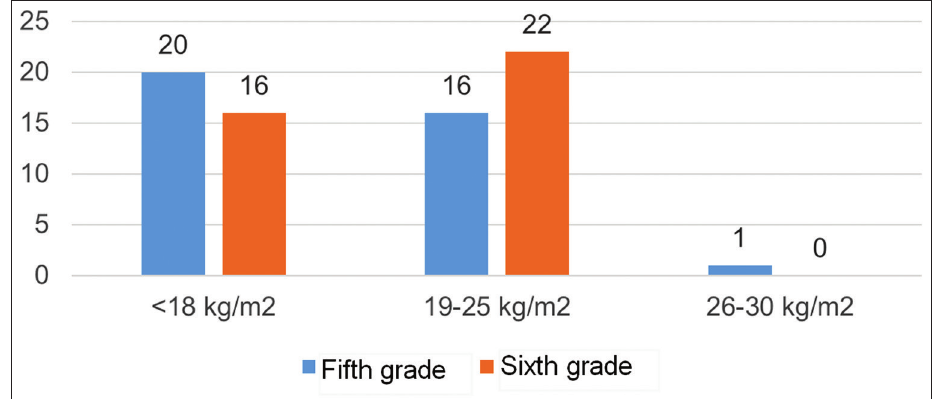
FIGURE 1. Groups of fifth‑ and sixth‑grade elementary school students according to the body mass